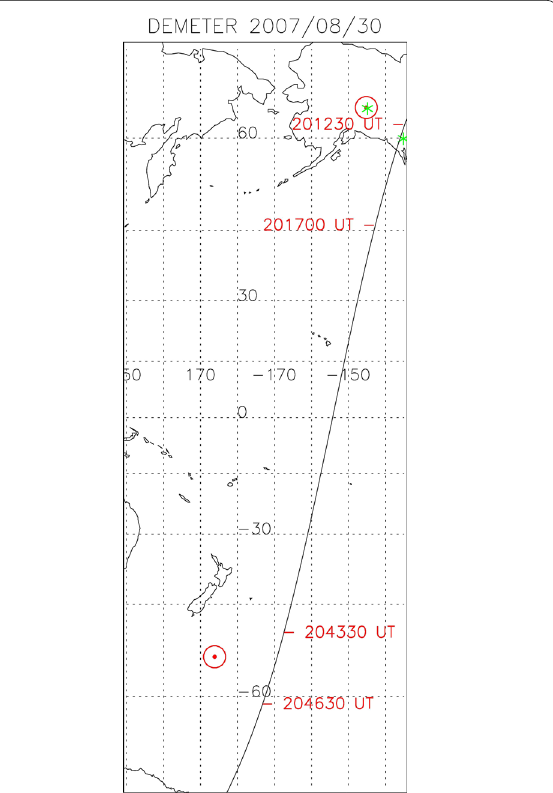
Fig. 7 Orbit of DEMETER on August 30, 2007 with times showing the positions of HAARP and its conjugate. The ground receivers at Chistochina and Juneau are indicated by a green